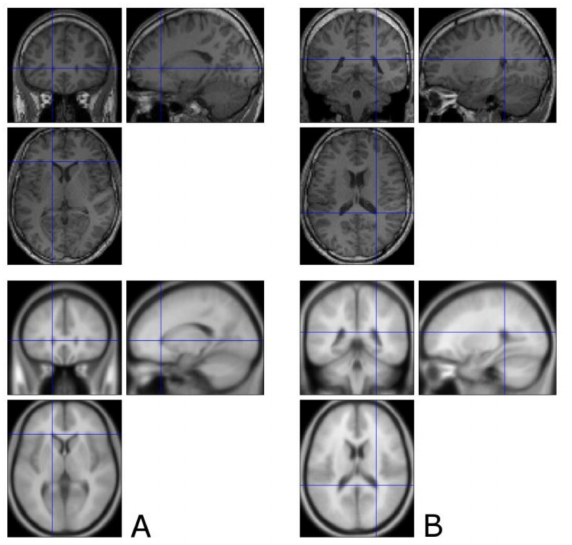
Figure A2. Visual inspection of registration quality during normalization using the CheckReg tool implemented in SPM comparing the location of several anatomical landmarks such as the edges of the ventricles (( A ): ventral part, ( B ): dorsal part), showing a good correspondence between the template space (lower part) and the non-linearly deformed single-subject T1-weighted image (upper part).